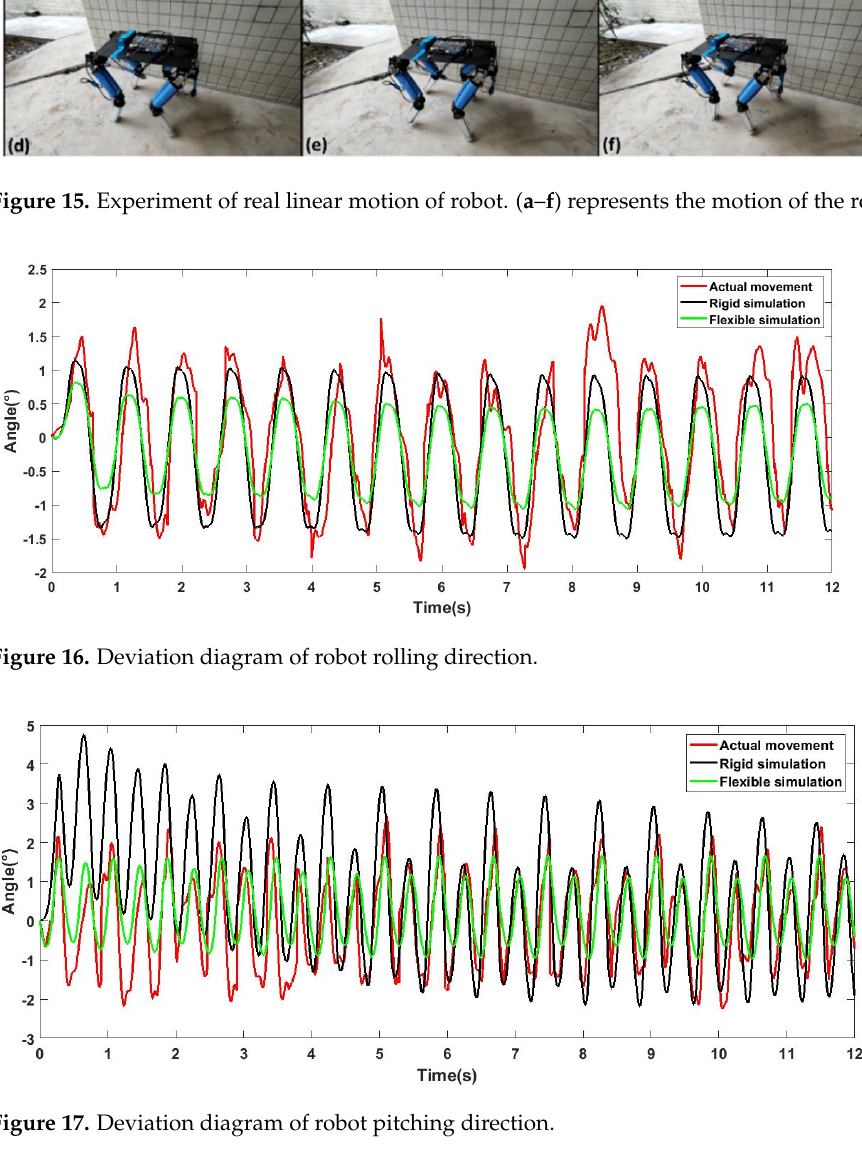
Figure 18. Deviation diagram of robot yawing direction.